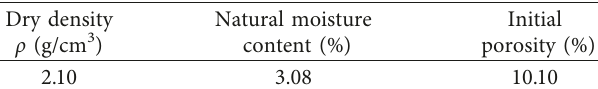
Table 2: Original physical parameter of sandstone. Dry density